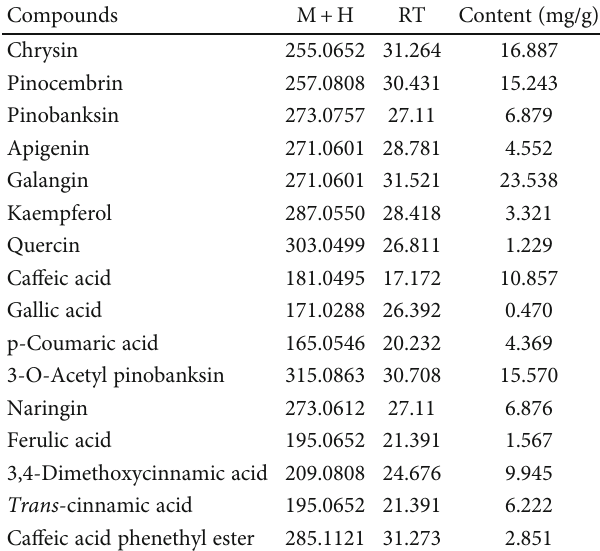
Table 2: The chemical constituents of EECP identi fi ed by HPLC- DAD/Q-TOF-MS